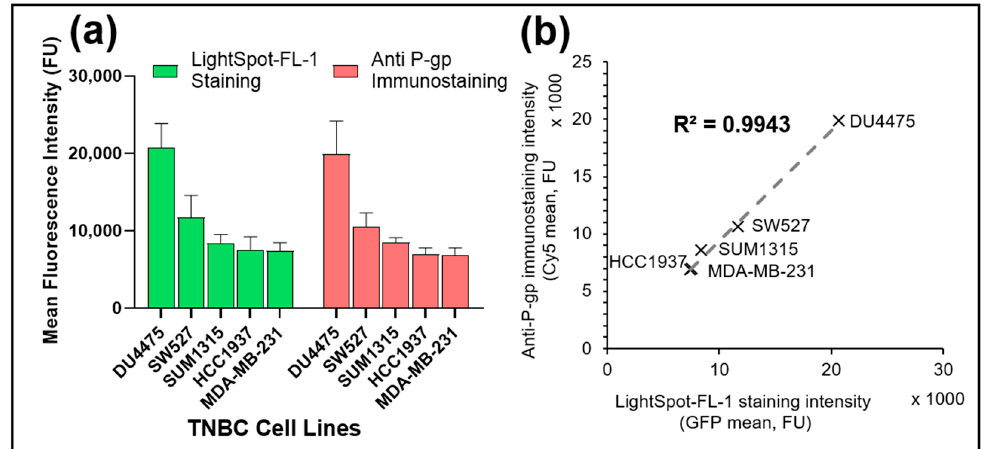
Figure 5. P-gp level quantification comparison after co-staining with LightSpot ® -FL-1 staining and anti-P-gp immunostaining on several triple-negative breast cancer cell lines. Co-staining was carried out by combining LightSpot ® -FL-1 staining with anti-P-gp immunostaining on five different TNBC cell lines i.e., DU4475, SW527, HCC1937, MDA-MB-231 and SUM1315. For each cell line, ( a ) both LightSpot-FL staining (green bars) and anti-P-gp immunostaining (red bars) fluorescence intensities were measured using the Gen5 software (BioTek ® ). Correlation between both stainings was evaluated ( b ) with the correlation line and the R² coefficient of determination.